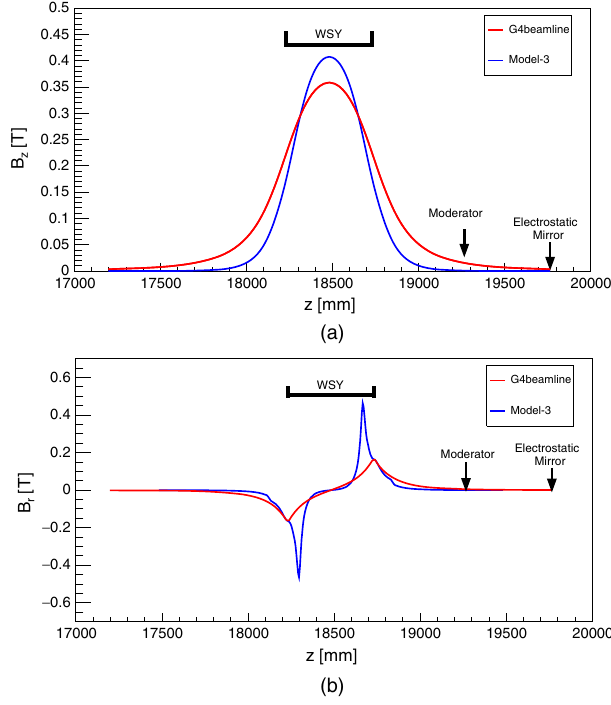
FIG. 17. Model 3: the stray field B z along the EM-S beam section. The main coil (MC) works at a current density of 3 A = mm 2 and the compensation coils (CC) work at 0 . 7 A = mm 2 with opposite current direction.